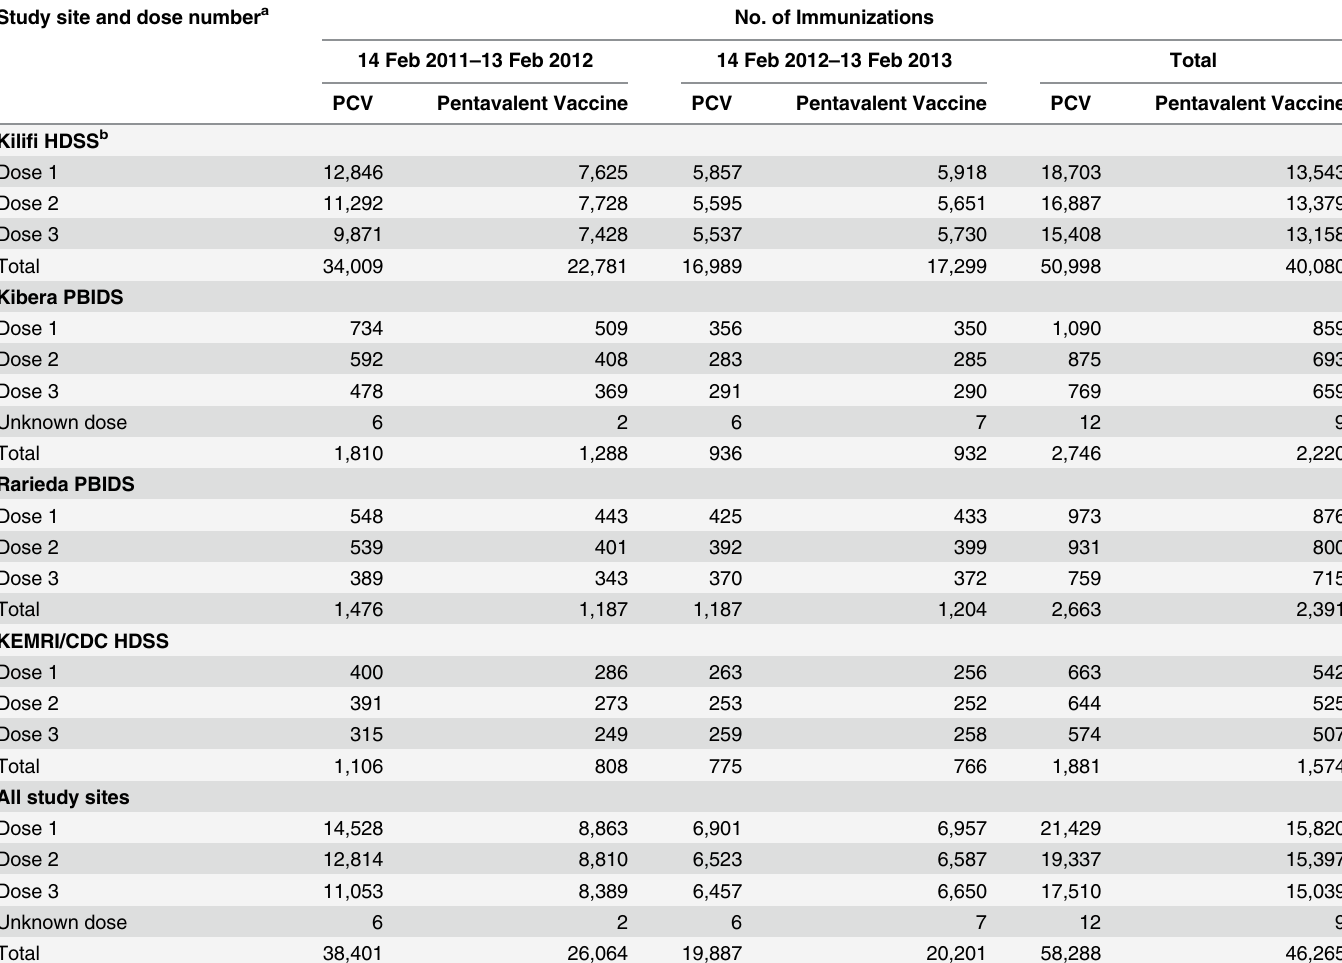
Table 1. Number of pneumococcal conjugate vaccine (PCV10) and pentavalent vaccine immunizations administered to infants in VAEIK study sites according to dose number, Kenya, 14 February 2011 – 13 February 2013. Study site and dose number a